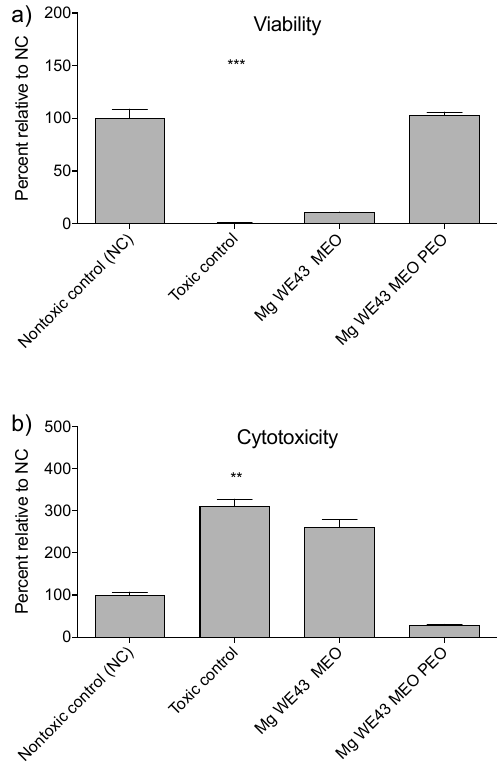
Figure 5. Extract assay results, ( a ) viability, ( b ) cytotoxicity. Asterisks show the results of Kruskal– Wallis tests followed by Dunn’s multiple comparison tests and indicate values that are significantly different from the nontoxic control. **: p ≤ 0.01 and ***: p ≤